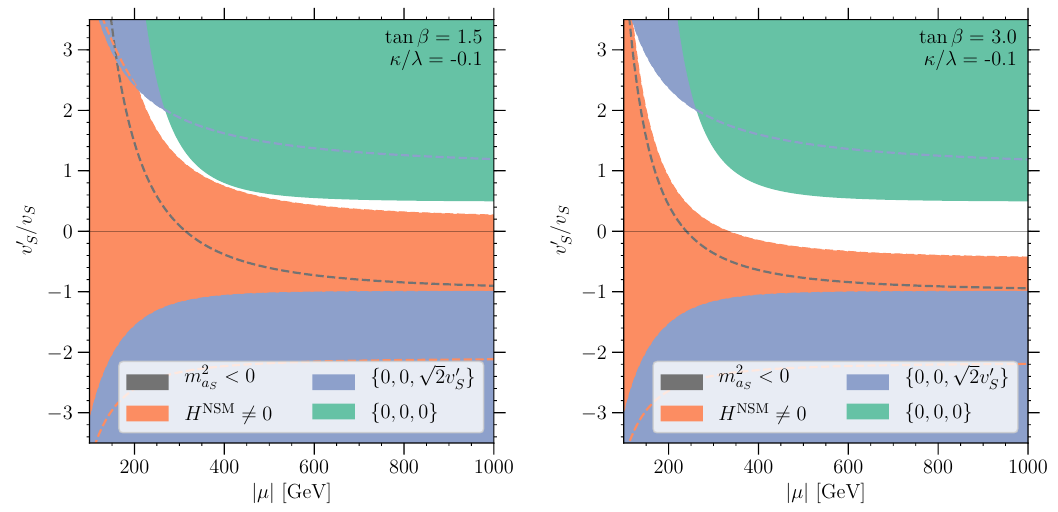
Figure 1 . The white region indicates the region of NMSSM parameter space where (in the align- √ ment limit) the physical minimum (cid:8) H SM , H NSM , H S (cid:9) = 2 { v, 0 , v 0 } is the global minimum of the S potential. In the gray region labeled as m 2 < 0 , the singlet-like CP-odd state becomes tachyonic, a S see eq. (2.50). In the orange region labeled as H NSM 6 = 0 , there exist minima with H NSM 6 = 0 that are deeper than the physical minimum (they are only found numerically). In the blue region √ √ (cid:9) , there exists a minimum at (cid:8) (cid:9) = (cid:8) 0 (cid:9) deeper than labeled (cid:8) 0 , 0 , 2 v 0 2 v 0 H SM , H NSM , H S , 0 , S S the physical minimum, see eq. (2.49). Similarly, in the green region labeled { 0 , 0 , 0 } , the trivial minimum is deeper than the physical minimum, see eq. (2.46). The regions are shaded on top of each other in the order described in this caption; the dashed lines of the respective colors mark the edges of the respective regions where overlapping. In the figures, we chose tan β = 1 . 5 ( tan β = 3 ) for the left (right) panel, and κ/λ = − 0 . 1 for both